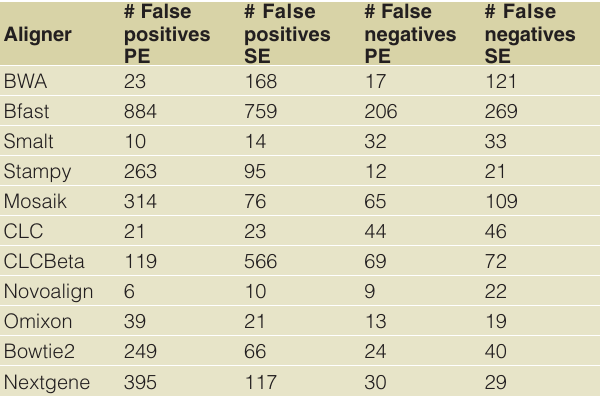
Table 5. Raw numbers of false positive and negative mutations detected across 67 groups of simulated Illumina reads following alignment with each aligner in single and paired-end mode. Each read group contained 20 SNPs and 13 INDELs.